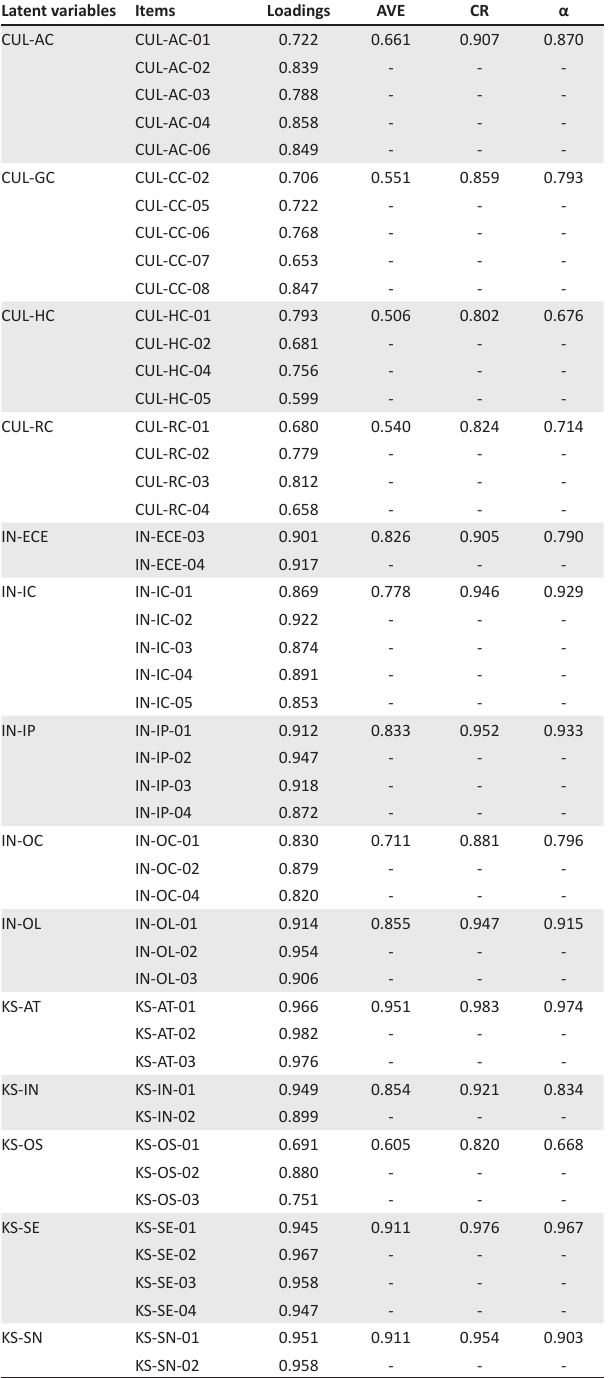
TABLE 1: Measurement model: First-order latent variables. Latent variables Items